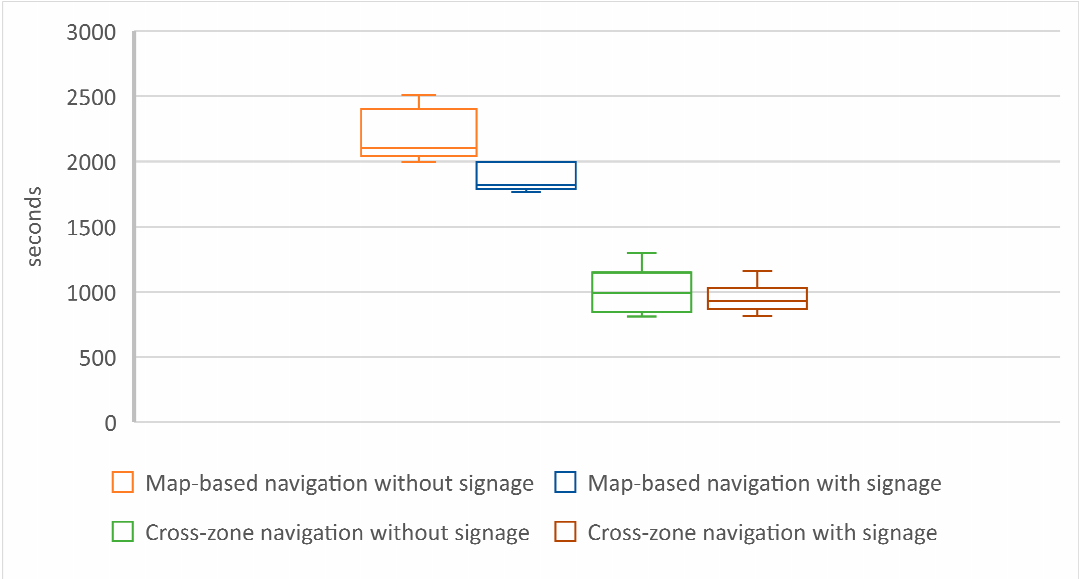
Figure 14. Box-and-whisker plot of object-seeking times for four different system combination groups.